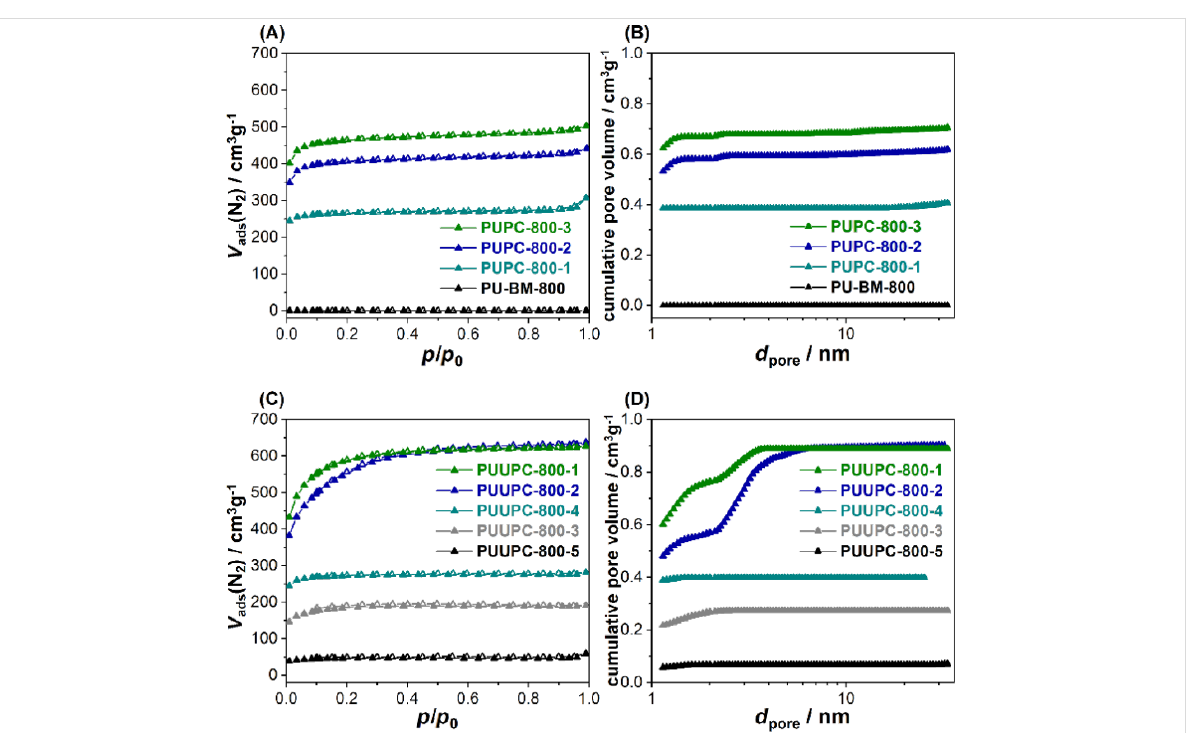
Figure 2: (A, C) Nitrogen adsorption/desorption (filled symbols/empty symbols) isotherms (measured at − 196 °C) and (B, D) cumulative pore size dis- tribution (PSD) using QSDFT with cylindrical/slit-shaped pores of the samples (A, B): PUPC-800-1 (cyan), PUPC-800-2 (blue), PUPC-800-3 (green), and PU-BM-800 (black) and the samples (C, D): PUUPC-1-800 (green), PUUPC-2-800 (blue), PUUPC-3-800 (grey), PUUPC-4-800 (cyan) and PUUPC-5-800